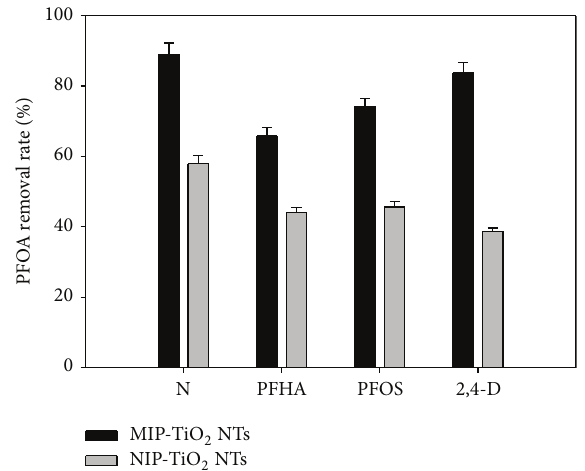
Figure 8: Decomposition selectivity of PFOA towards MIP-TiO 2 NTs in dual-solute solution in the presence of competitive pollu- tants. “N” represents only PFOA in the reaction solution.